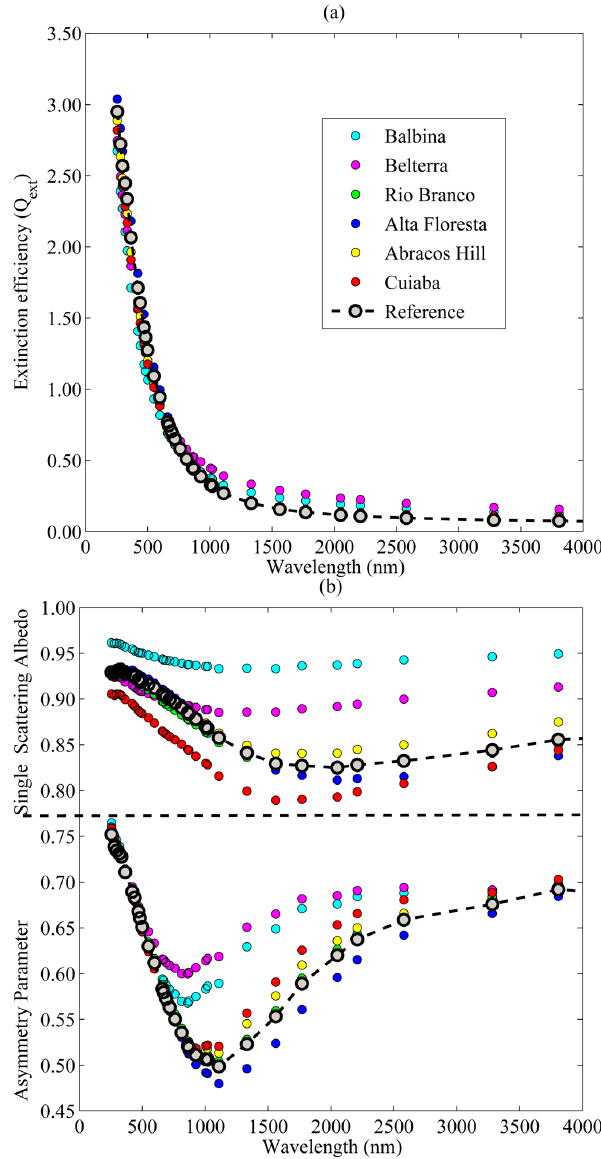
Fig. 2. Dynamic optical models (coloured circles) describing mean spectral dependence of smoke aerosol optical properties, i.e. (a) ex- tinction efficiency, (b) single scattering albedo and asymmetry pa- rameter obtained from a Mie code using as input the average size distribution and complex refractive index from each AERONET site. The reference optical model (dashed black line) was obtained using averaged size distribution and complex refractive index from the sites inside the burning areas of the southern part of the Amazon basin (Rio Branco, Abracos Hill and Alta